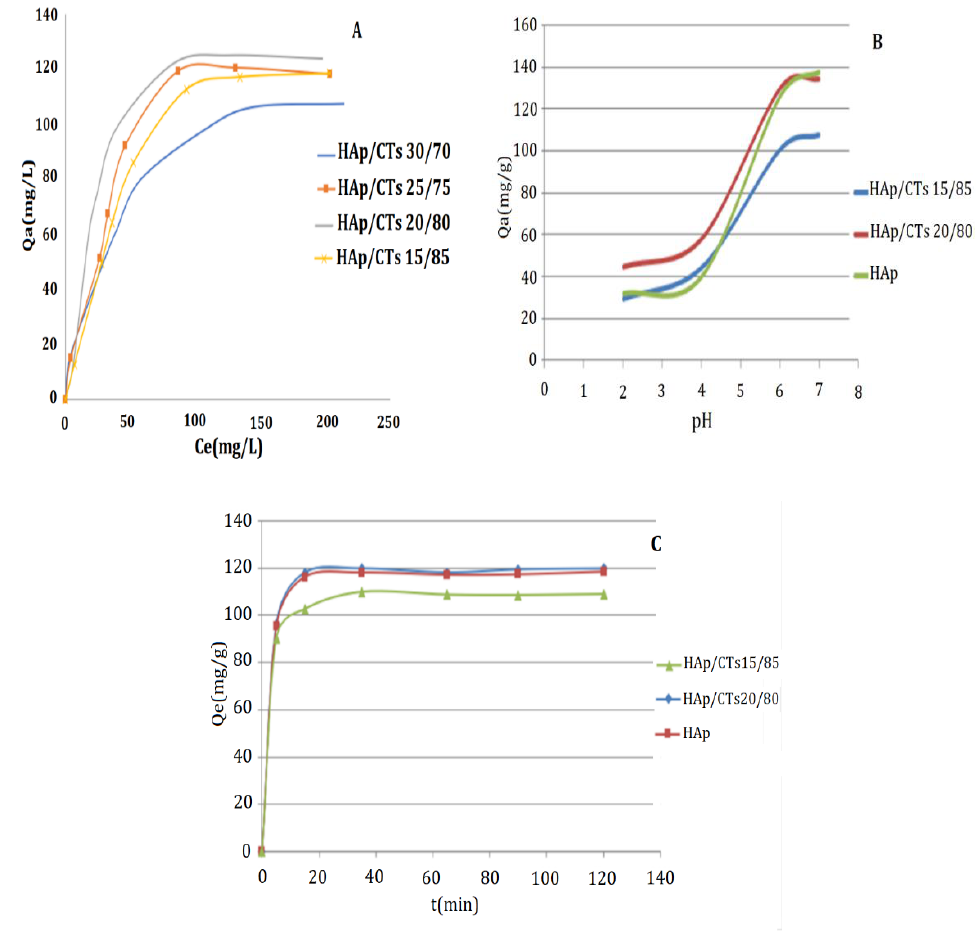
Figure 9. Effect of ( A ) initial concentration; ( B ) pH; and ( C ) contact time on the adsorption of Cd 2 on HAp/CTs composites.